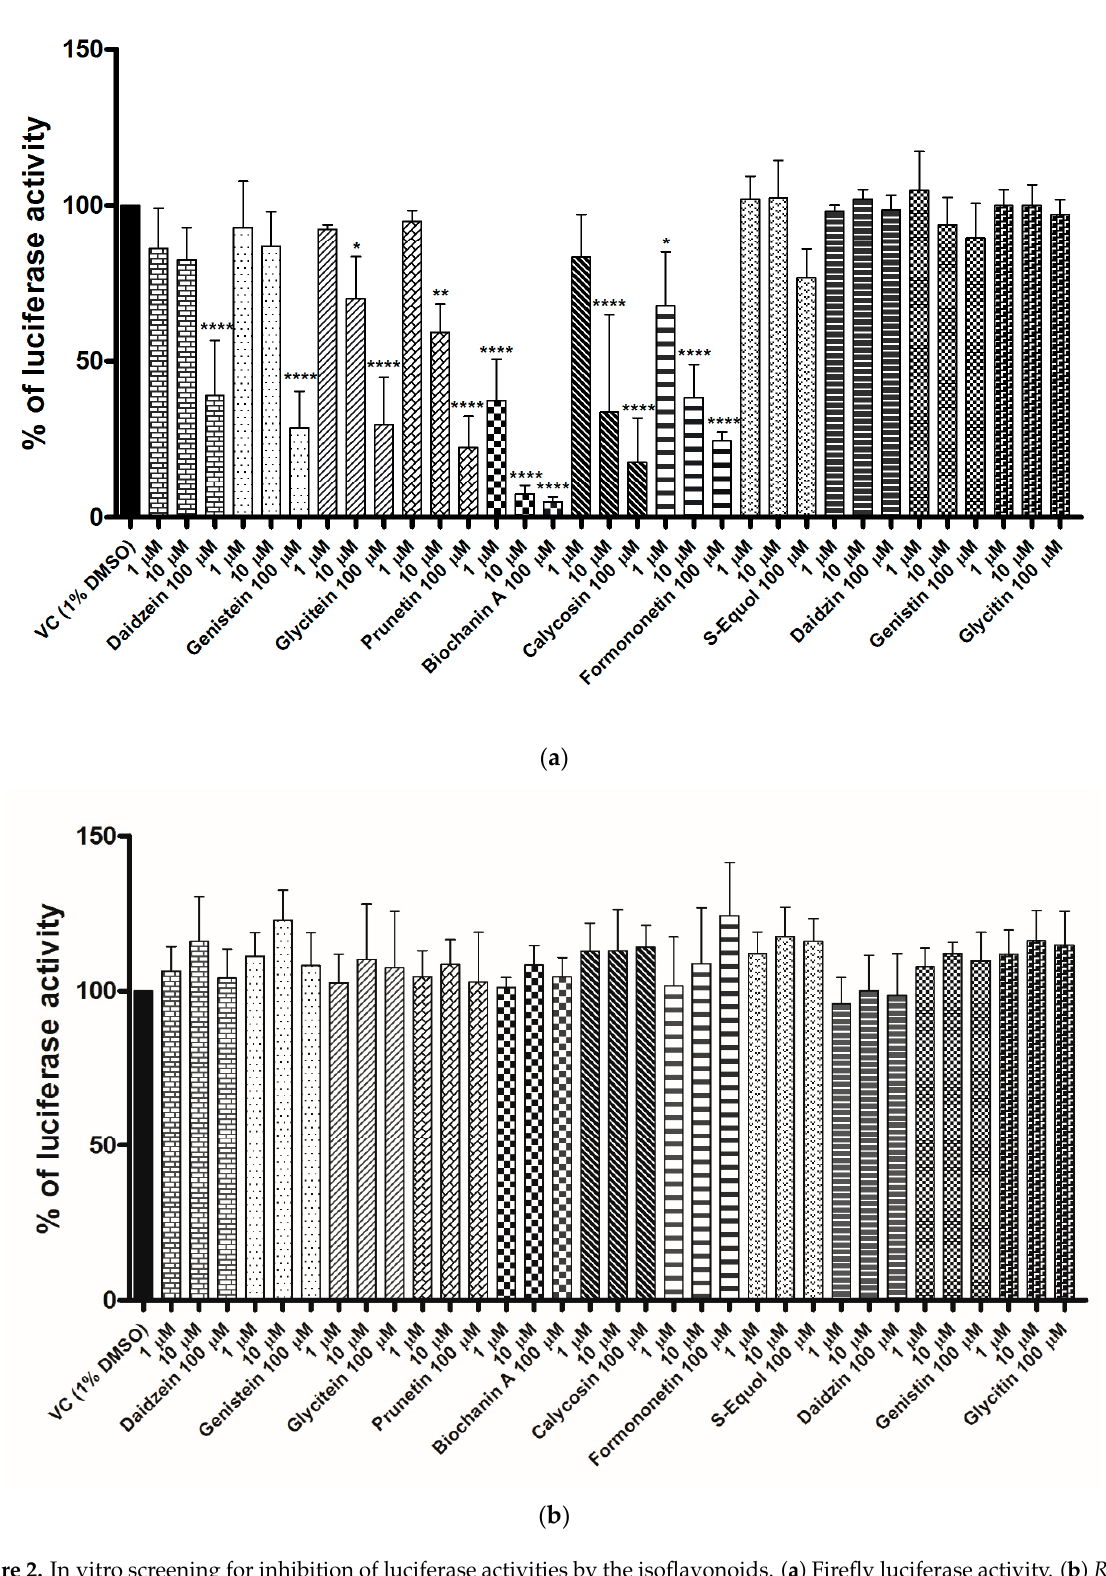
Figure 2. In vitro screening for inhibition of luciferase activities by the isoflavonoids. ( a ) Firefly luciferase activity. ( b ) Renilla luciferase activity. Data are defined as percentages of the vehicle control (VC) of 1% dimethylsulfoxide in the AR-EcoScreen cell lysates upon inclusion of the isoflavonoids (1, 10, 100 µM). Data are means ± standard deviation of three independent repeats in triplicates. *, p ≤ 0.05; **, p ≤ 0.01; ****, p ≤ 0.0001; vs. VC (one-way ANOVA, post-hoc Dunnett’s tests).